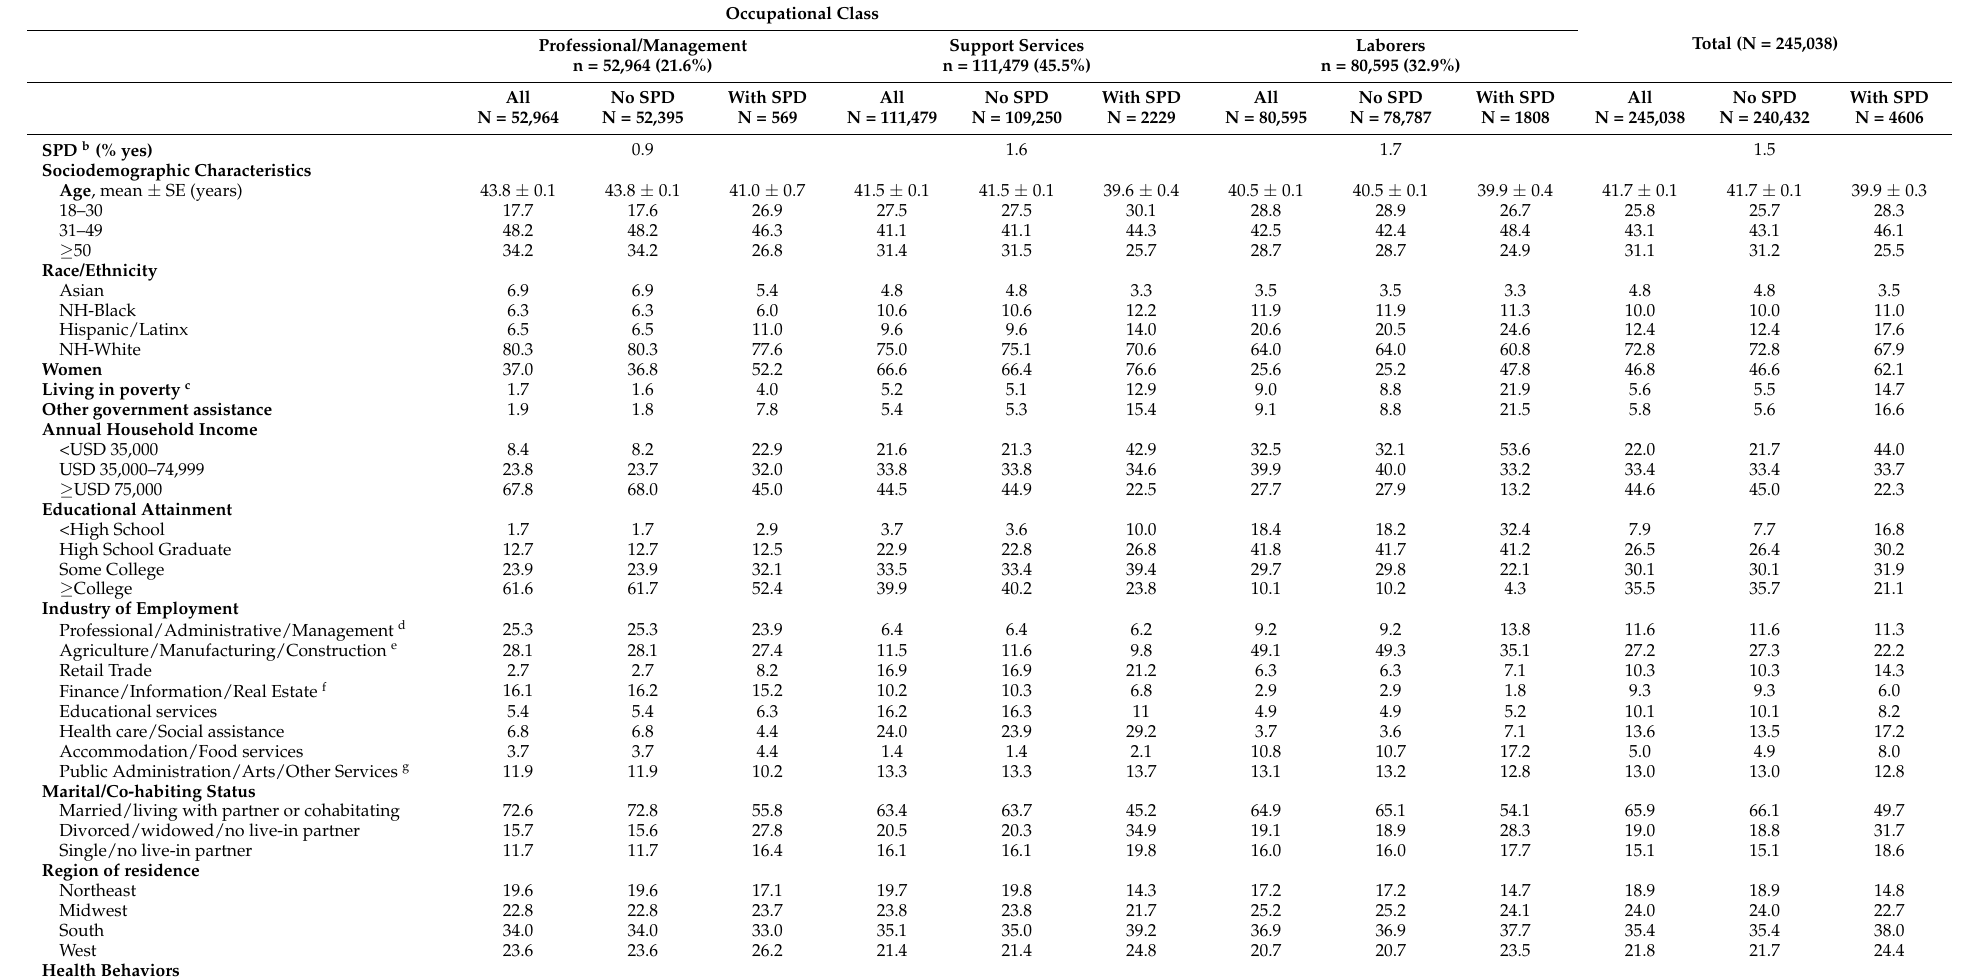
Table 1. Age-Standardized a Sociodemographic, Health Behavior, and Clinical Characteristics among U.S. Adults Overall, by Occupational Class, and stratified